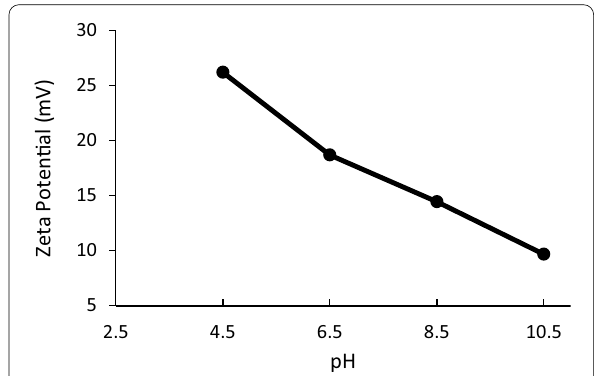
Fig. 4 Variation of zeta-potential of the modified fibers suspension (1 g/l) against pH. The surface charges of the synthesized fibers remained positive in the pH